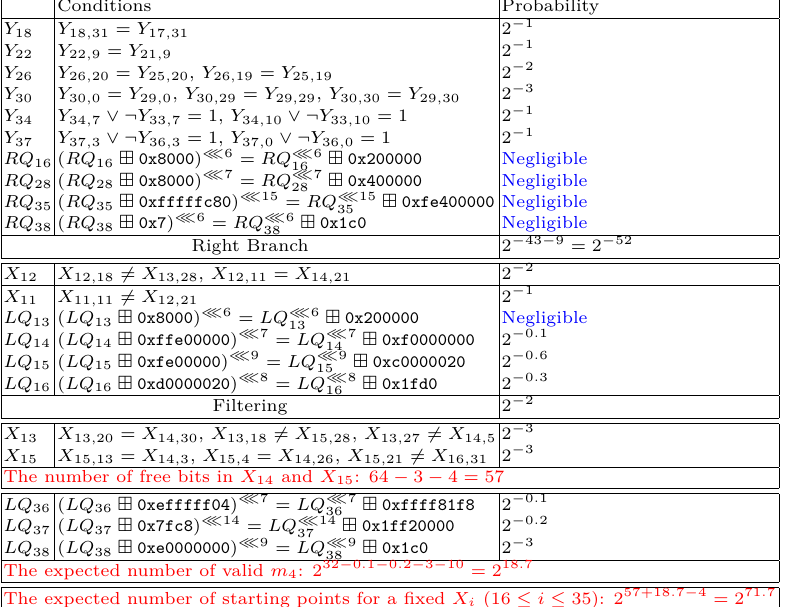
Table 9: Other conditions influencing the attack for the 38-step differential characteristic Conditions Probability Y